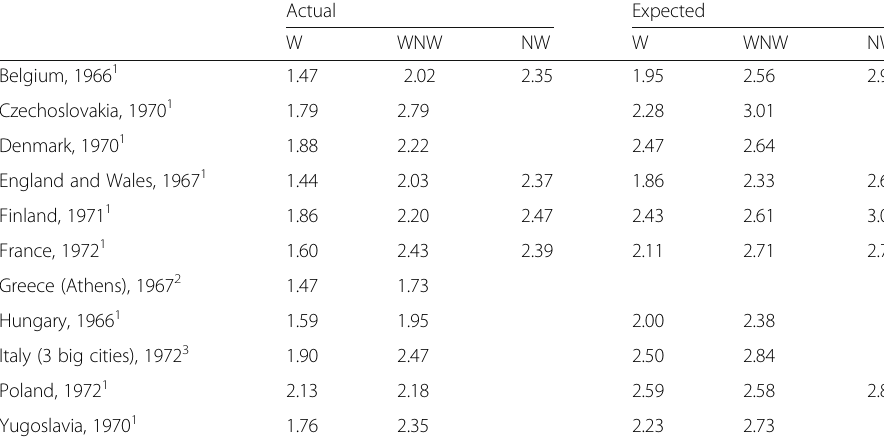
Table 5 Actual and expected number of children according to wife ’ s work Actual Expected W WNW NW W WNW NW